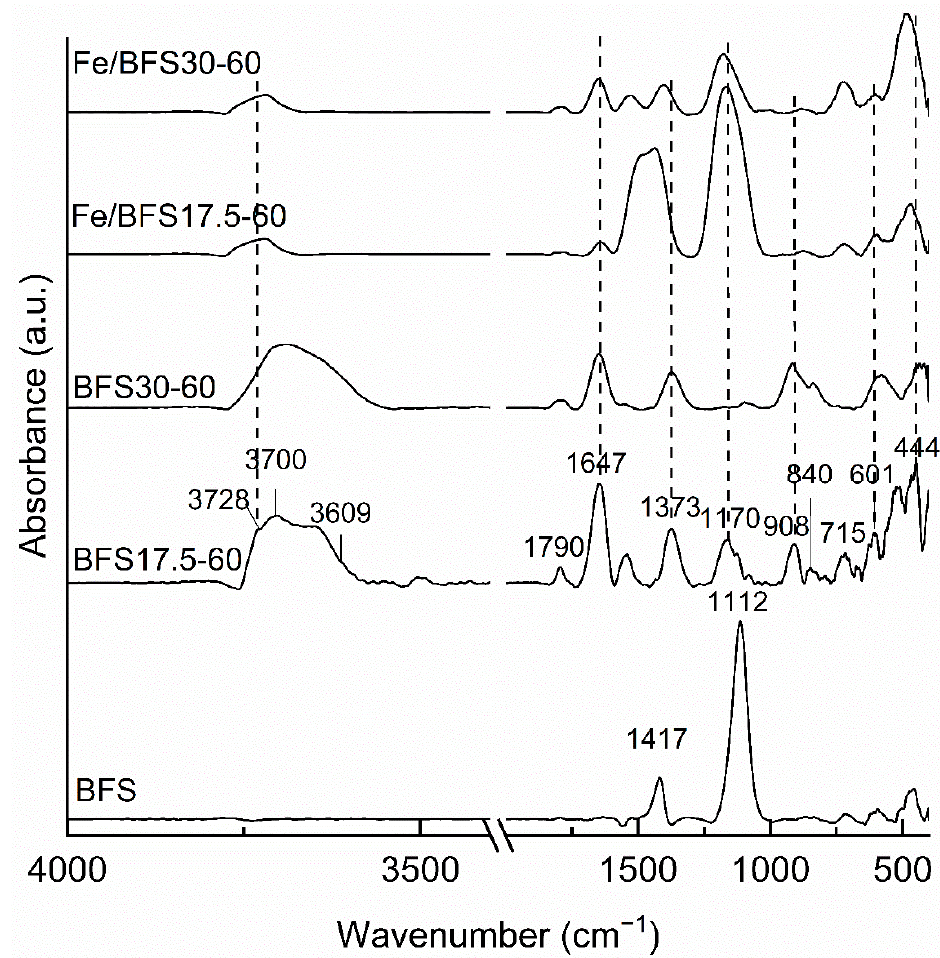
Figure 2. DRIFT spectra of BFS, BFS17.5-60, BFS30-60, Fe/BFS17.5-60, and Fe/BFS30-60 samples. Alkali-activated samples exhibited several peaks in the analyzed region. The peak at 3730 cm − 1 for BFS17.5-60 corresponded to silanol groups, which interact with other atoms—for example, in silanol nests [47]—and the absorption peak at ~3700 cm − 1 revealed the presence of four coordinated Al [48]. Moreover, the band at 3610 cm − 1 for BFS17.5-60 corresponded to the bridging hydroxyl groups [49]. In the DRIFT spectra of Fe/BFS17.5-60 and Fe/BFS30-60, the peak centers were shifted to higher wavenumbers than those for the samples without iron, probably due to calcination, and the absorption band corresponding to the silanol groups (3730 cm − 1 ) disappeared by the introduction of iron into AAMs [47]. The absorbance bands for BFS17.5-60 and BFS30-60 were observed at 715, 840, 1373, and 1790 cm − 1 , corresponding to CO 32 − -containing compounds [46]. Bands at 840 and 1790 cm − 1 connected to Na 2 CO 3 , and the band at 715 cm − 1 corresponded to CaCO 3 [46], while that observed at 1373 cm − 1 corresponded to hydrotalcite [50], which was also detected in the X-ray diffractograms of these samples (Figure 1). In the DRIFT spectra of Fe/BFS17.5-60 and Fe/BFS30-60, these peaks were slightly shifted to higher wavenumbers, especially for the band corresponding to hydrotalcite, indicative of its decomposition as a result of heat treatment. Furthermore, the peak at ~1650 cm − 1 observed in all samples corresponded to the H–OH stretching vibrations characteristic of absorbed water [51], the intensity of which slightly decreased due to the heat treatment of iron-containing samples. All AAMs exhibited several bands corresponding to the Al and Si bonds. The bands at 435–483 cm − 1 corresponded to the Si–O–Si and O–Si–O bending vibrations [52], while the absorption peak at ~600 cm − 1 revealed the presence of Si–O–Si and Al–O–Si symmetric stretching vibrations [53]. The band at ~900 cm − 1 in the spectra of BFS17.5-60 and